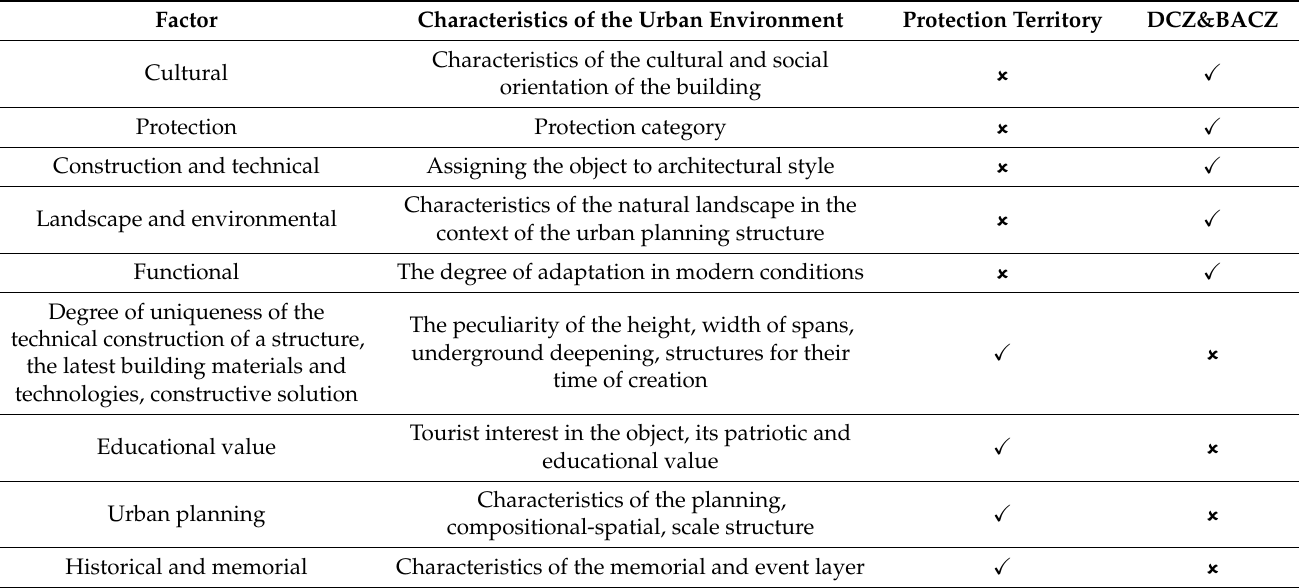
Figure 12. Pectin-PEGMA solution turned white after the addition of α -CD: ( a ) original 10% P-10K solution; and ( b ) 10% P-10K solution after the addition of α -CD (10%).